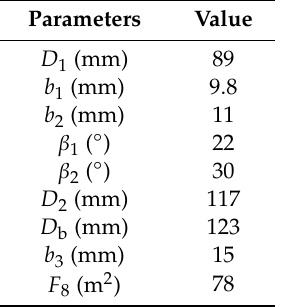
Table 2. The main geometrical parameters.